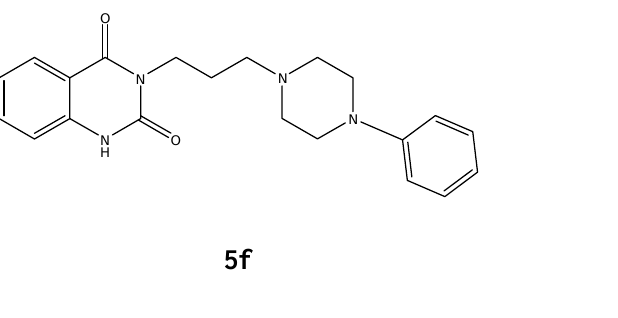
Figure 1. Examples of quinazoline-2,4- diones: Pelanserine ( 5f ) a potent anti-hypertensive agent, and two natural products [ 5 ( b,e